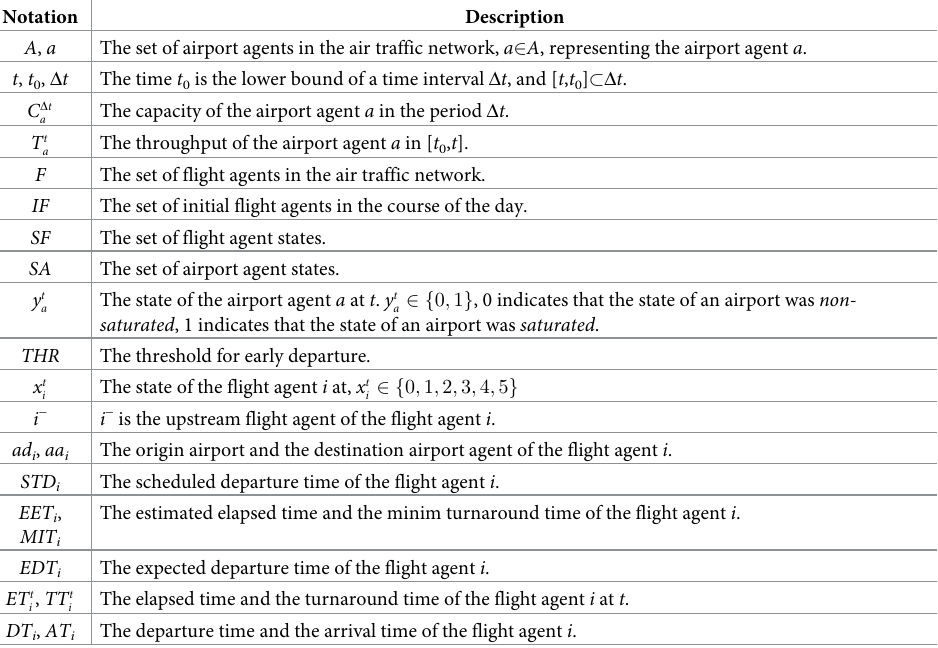
Table 1. Notations and